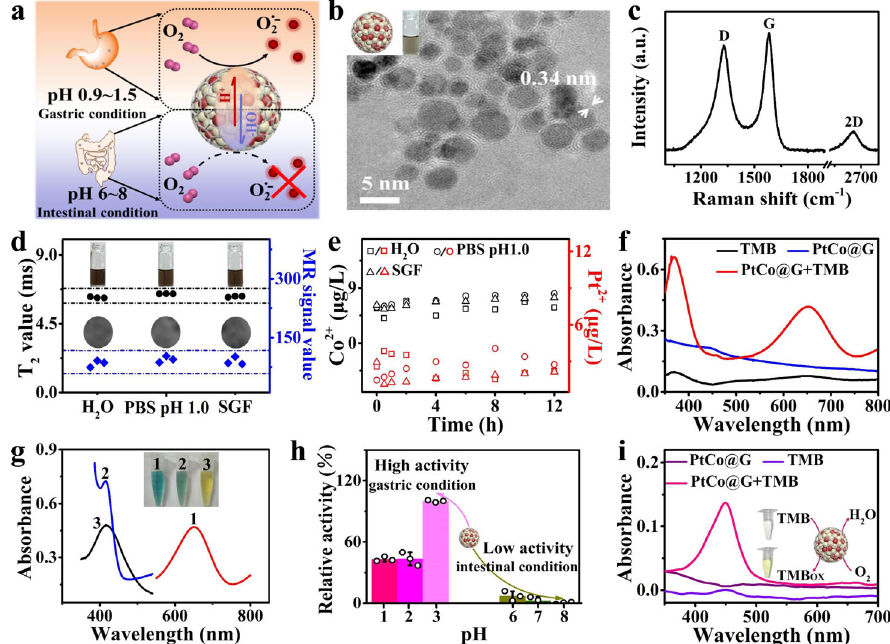
Fig. 1 Characterization of pH-responsive graphitic nanozyme. a Schematic illustrating selective activated pH-responsive oxidase-like activity of PtCo@G in gastric acid conditions. b TEM image of PtCo@G. Insert shows corresponding structure diagram of PtCo@G (including the PtCo nanocrystal core and graphitic shell) and digital photos of the PtCo@G solution. c Raman spectrum of PtCo@G. d The digital photos, MR T 2 relaxivity, T 2 -weighted phantom images and corresponding quantitative data analysis on T 2 -weighted phantom images of PtCo@G in H 2 O, PBS (pH 1.0), and SGF after 12 h incubation. e Pro fi les for Co 2 + and Pt 2 + release from PtCo@G nanocrystals in H 2 O, PBS (pH 1.0), and SGF. f UV-Vis absorbance spectra of TMB in different reaction systems: TMB, PtCo@G, and PtCo@G + TMB in a pH 4.0 PBS buffer after 30 min incubation. g PtCo@G catalyzes the oxidation of various substrates to produce different color reactions. (1) TMB, (2) ABTS, and (3) OPD. Insert images show corresponding visual color changes. h Selective activated pH- responsive oxidase-like activity of PtCo@G under gastric acid conditions. i Oxidase-like activity of the PtCo@G in SGF. Insert images show corresponding visual color changes and the reaction between TMB and PtCo@G in SGF. The data indicate the means and SD from three parallel experiments. Source data are provided as a Source Data fi